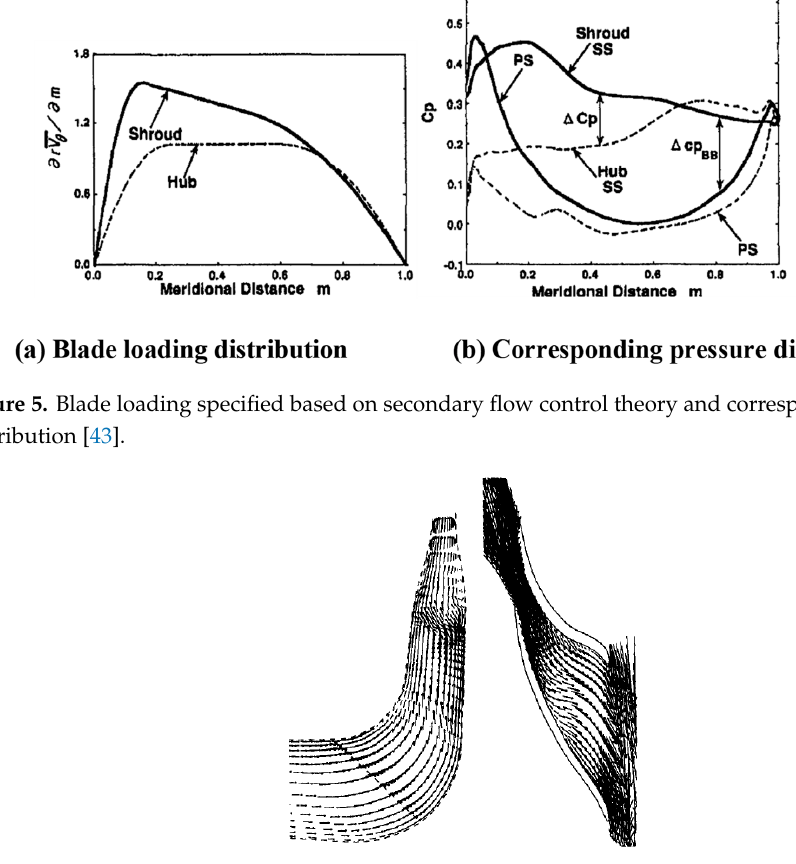
Figure 6. Simulated velocity vectors on both the suction surface and shroud surface of the blade [43].